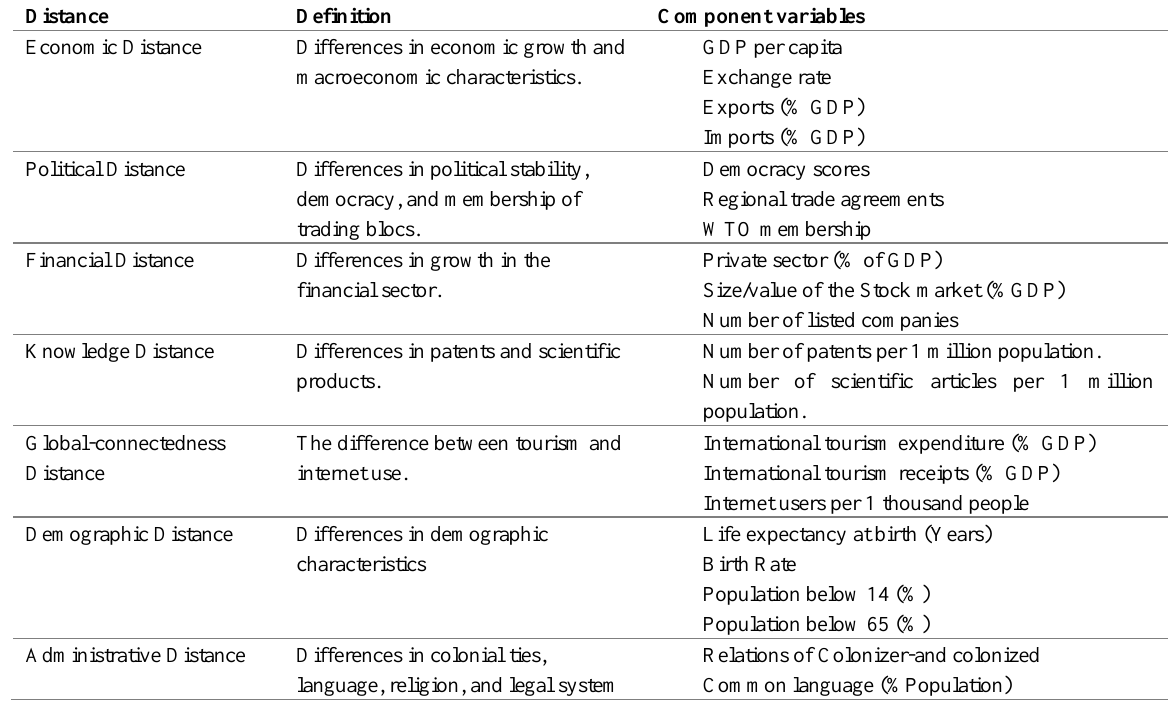
Table 1: Dimensions of Institutional Distance and Component